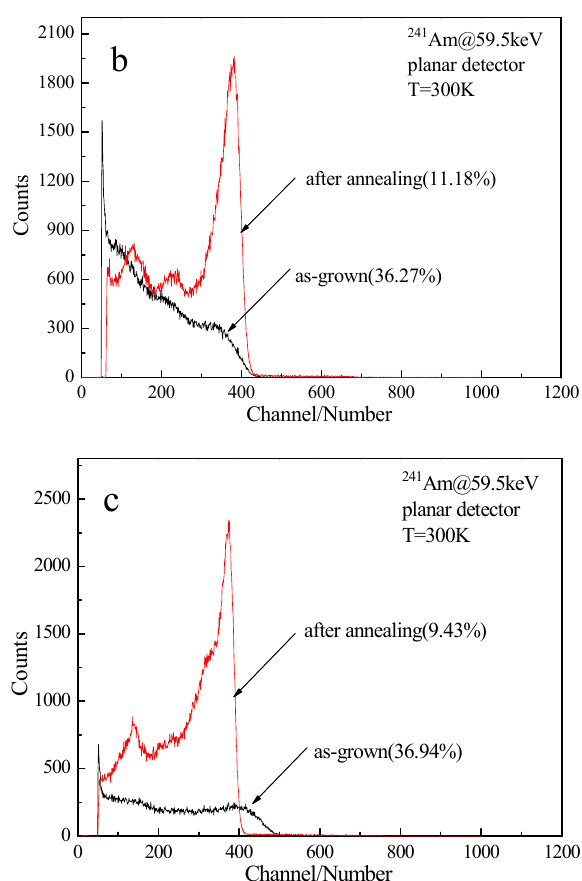
Figure 10. 241 Am γ -ray spectra of CMT detectors fabricated by as-grown and annealed CMT:In slices: ( a ) Cd atmosphere at 873 K for 240 h and Te atmosphere at 773 K for 120 h; ( b ) Cd atmosphere at 973 K for 240 h and Te atmosphere at 773 K for 120 h; ( c ) Cd atmosphere at 1073 K for 240 h and Te atmosphere at 773 K for 120 h.